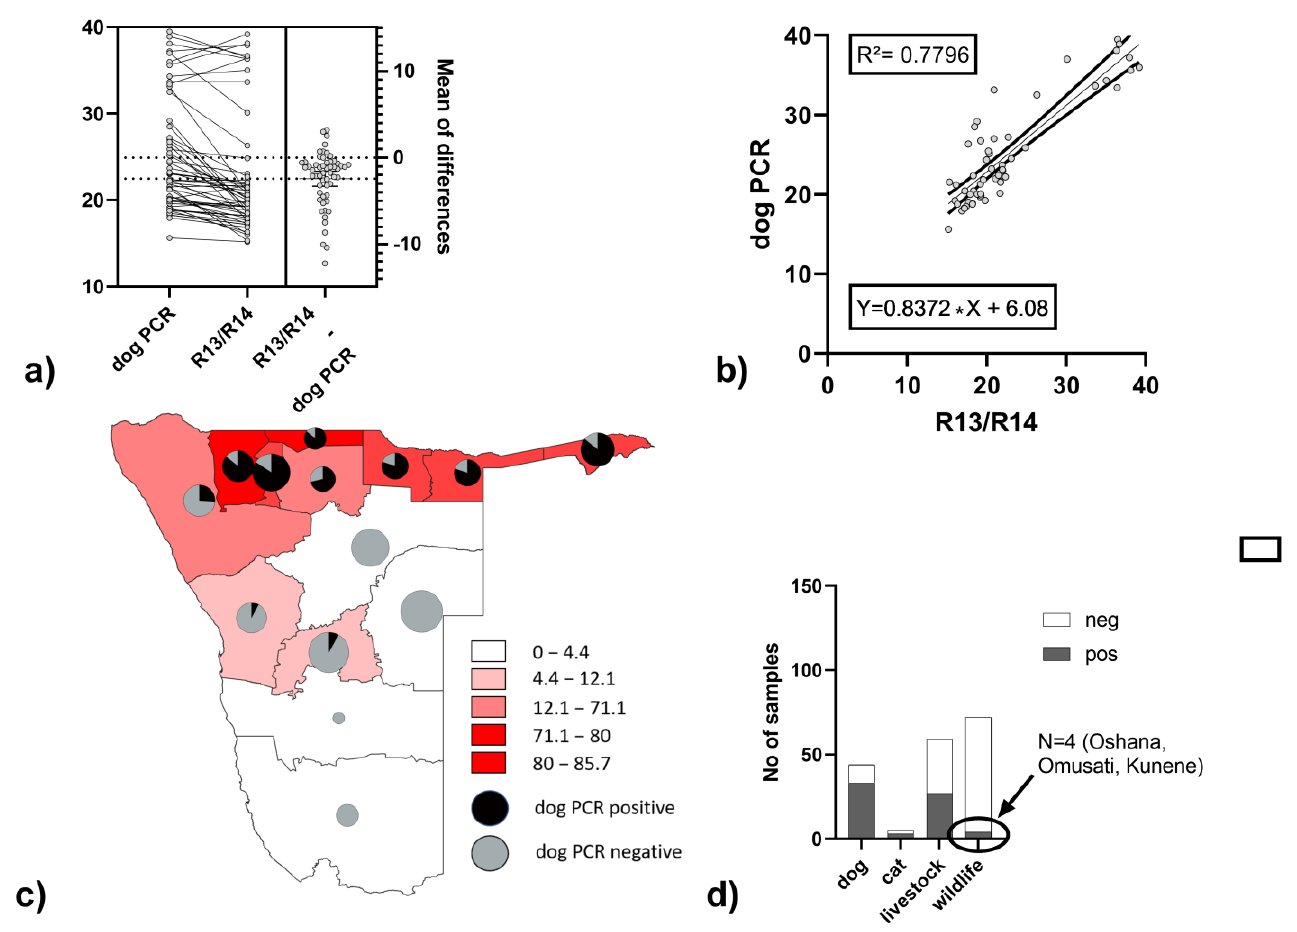
Figure 3. Comparison of the DogF1 assay with the standard FLI method (R13/14) and the mean of differences ( a ) and a linear regression analysis ( b ), display of DogF1 positives and negatives from R13/14 positives per region ( c ) and per species ( d ). Livestock include samples from cattle, sheep and goats.